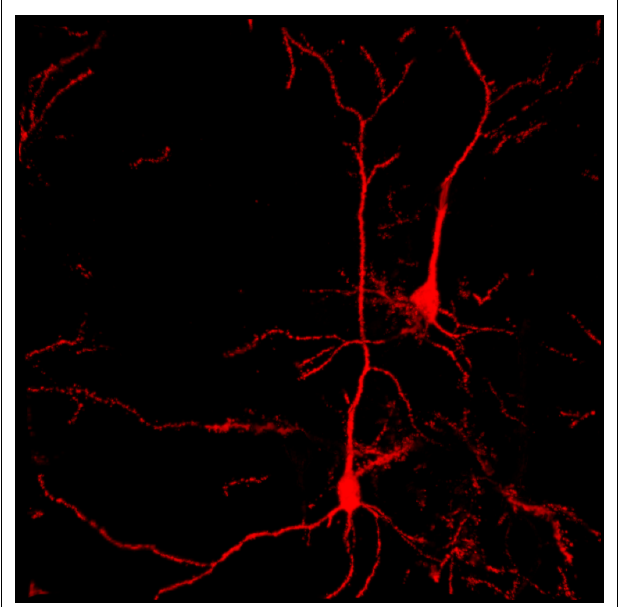
FIGURE 1 | Confocal reconstruction of Golgi-stained pyramidal neurons from DLPfcx obtained by a projection of 55 scans for a depth of 27.5 μ m in the z -axis. DLPfxc may represent a useful target for rTMS stimulation.